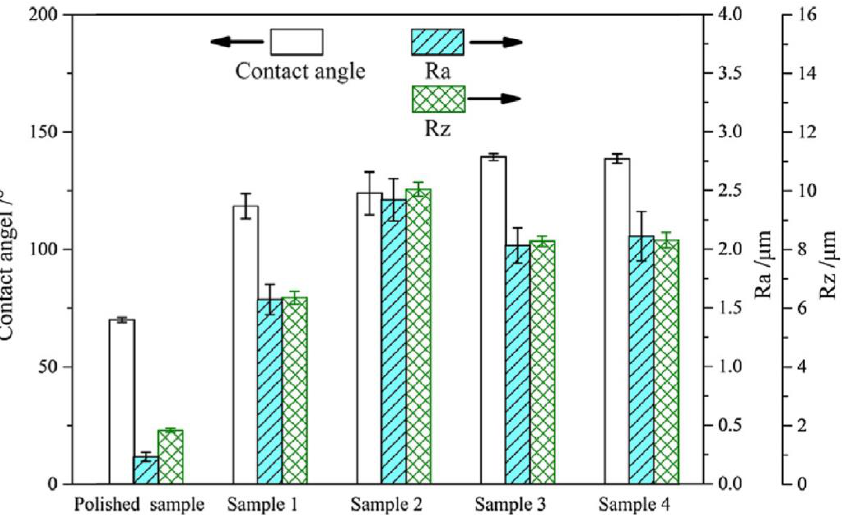
Figure 9. Relationship between the roughness (Ra and Rz) and the WCA of samples machined by the process of EDM [23].